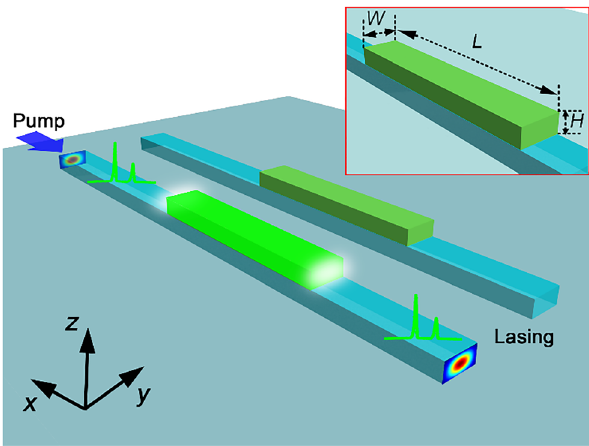
Figure 1: Schematic of the IPWP method with a localized waveguide source. Inset is the zoomed-in view of a high-index gain dielectric